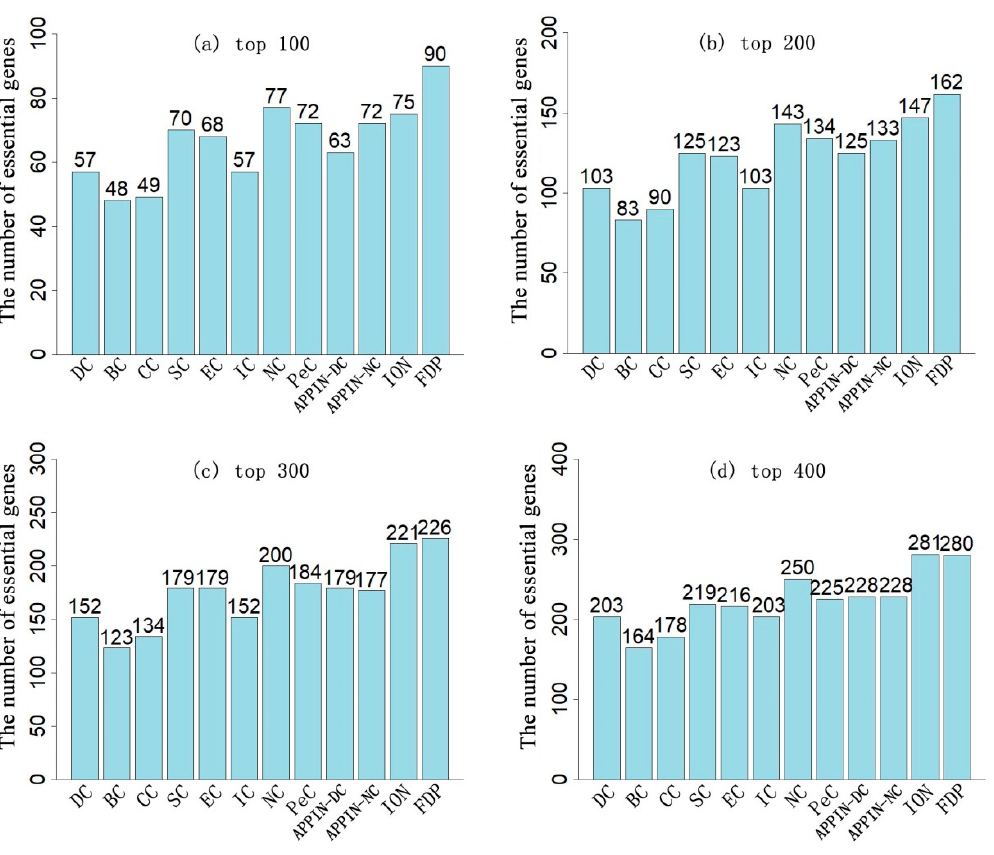
Figure 3. Comparison of the number of essential genes identified by the FDP and other existing methods based on the SC_net network. ( a – d ) respectively show the results of these methods when selecting top 100, 200, 300, and 400 of the ranked genes as candidate essential proteins. The data labels above the bars are the number of true essential proteins identified by corresponding methods in each top number of ranked genes.